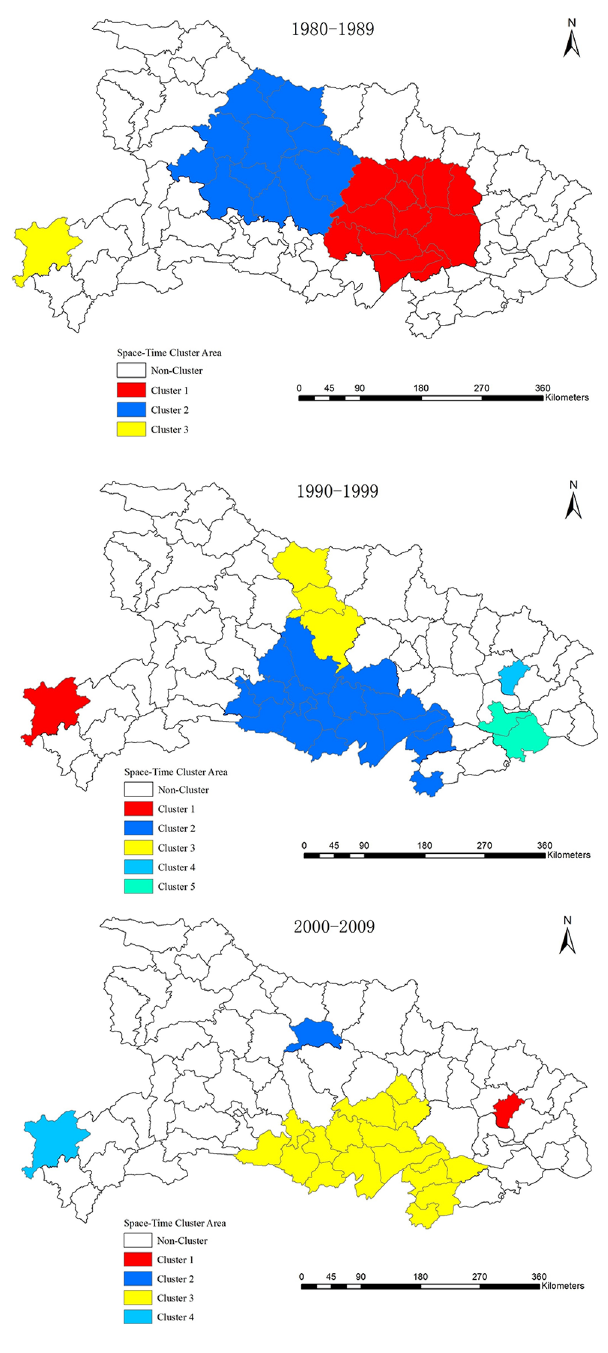
Figure 4. Space-time distribution of identified clusters of HFRS in Hubei Province, China. One most likely cluster and two secondary clusters were identified during the 1980’s. The most likely cluster was comprised of 13 counties (Anlu, Jingshan, Xiaogan, Huangpi, Ying- cheng, Yunmeng, Tianmen, Hanchua, Wuhan, Qianjiang, Xiantao, Jiayu and Honghu) for the period 1982–1985. One most likely cluster and four secondary clusters were identified during the 1990’s. Lichuan was the most likely cluster from 1990 to 1994. One most likely cluster and three secondary clusters were identified in the 2000’s. The most likely cluster area was found in Huanggang in